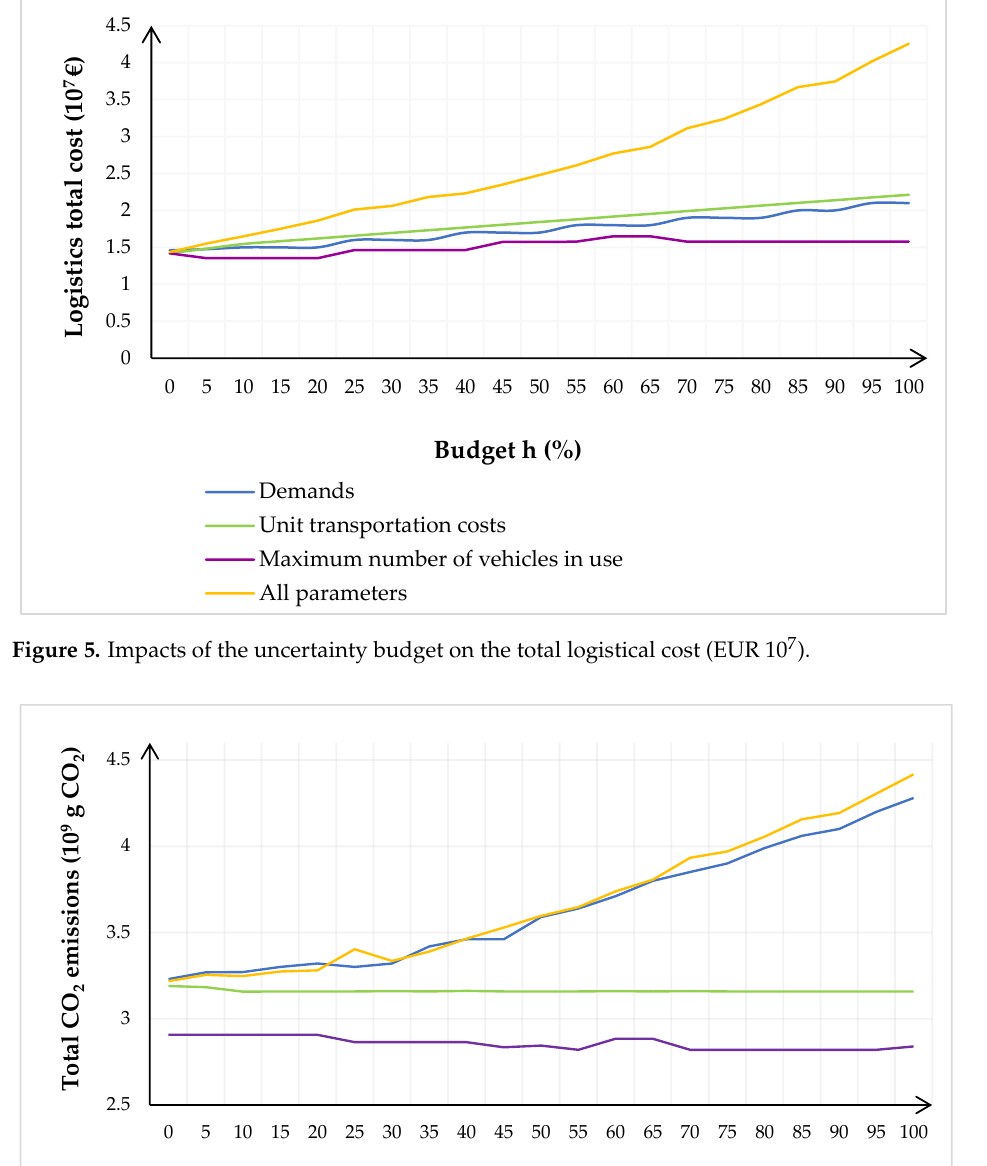
9 g CO 2 total emissions (10 2